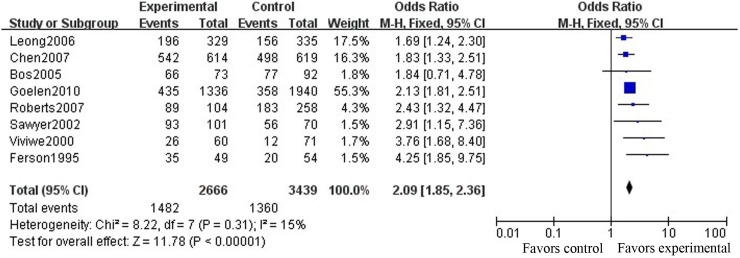
Comparison of the FUR between the telephone and the control groups.